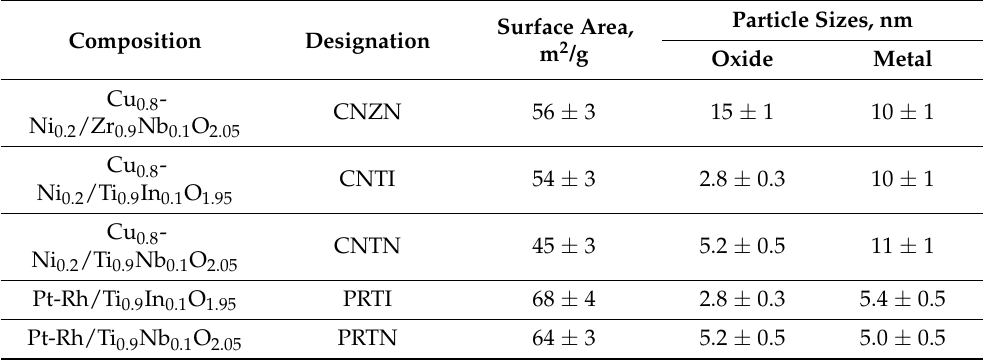
Table 1. Composition, designation, particle size and surface area of the obtained samples.